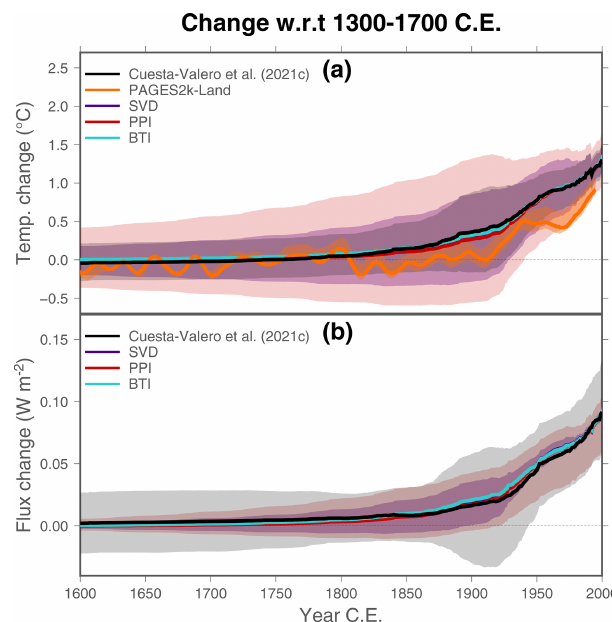
Figure 7. (a) Ground surface temperature histories from the three techniques analyzed here using the Xibalbá dataset in comparison with previous results from Cuesta-Valero et al. (2021c) (black) and the PAGES2k-Land temperatures (orange). (b) Ground heat flux histories from the three techniques analyzed here using the Xibalbá dataset in comparison with results from Cuesta-Valero et al. (2021c) (black). Results from the BTI technique in both panels consider Sampling and Bootstrapping ensembles with 1079 and 1000 mem- bers, respectively. Note that the uncertainty in BTI results is repre- sented, although difficult to visualize due to its small